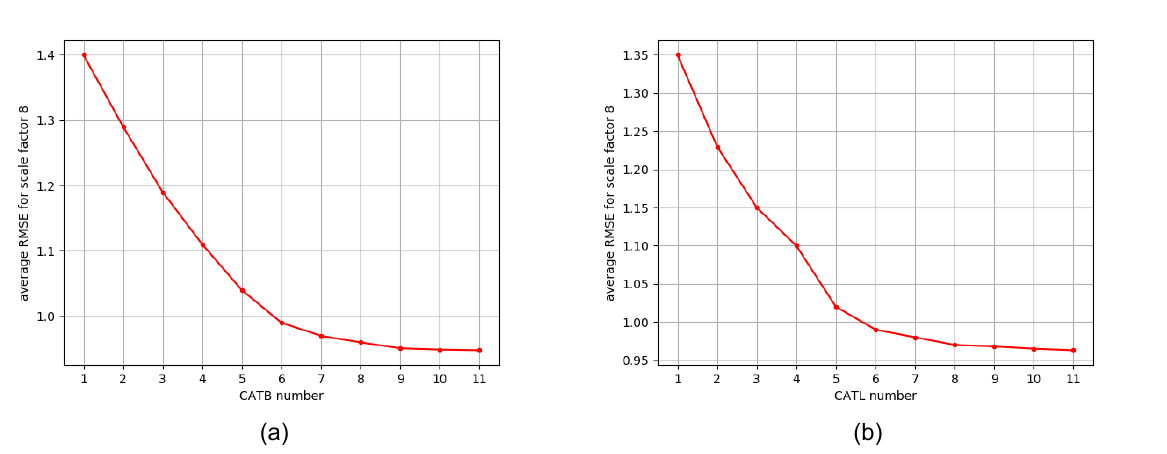
Figure 5. Ablation study on different configurations of the proposed CAGM. Results are the average RMSE on the noise-free Middlebury dataset for scaling factor 8. ( a ) The effect of the CATB number in the CAGM, and ( b ) the effect of CATL number in each